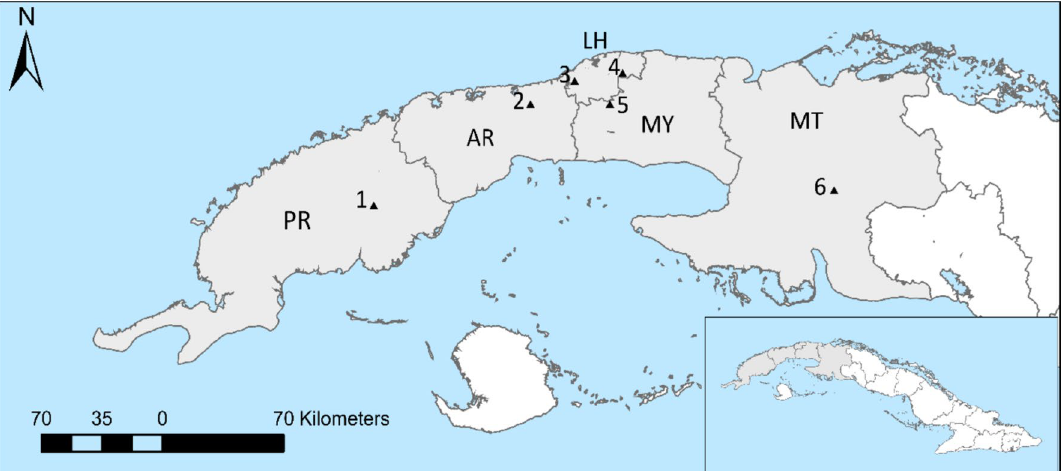
Figure 5. Black triangles represent the approximate locations of the six sampling apiaries in Western Cuba. Letters indicate the name of the provinces: Pinar del Rio (PR), Artemisa (AR), La Habana (LH), Mayabeque (MY), Matanzas